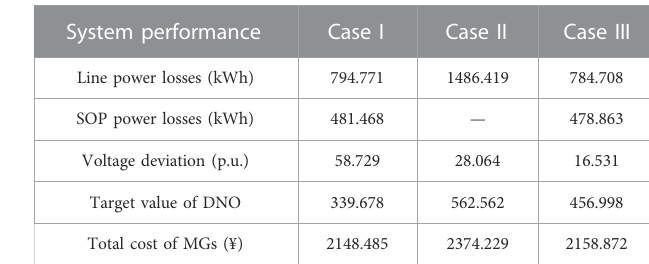
TABLE 3 Comparison results under different